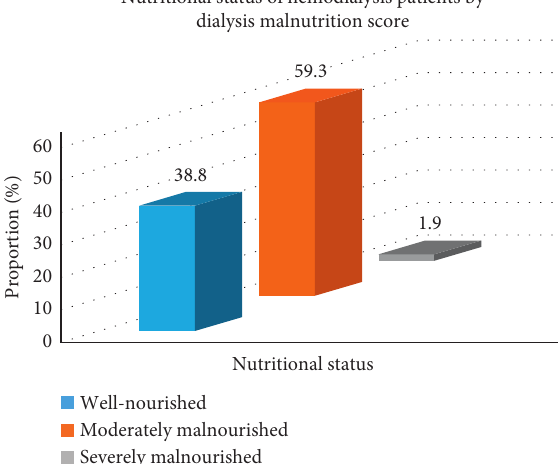
Figure 1: Nutritional status of hemodialysis patients by dialysis malnutrition score.